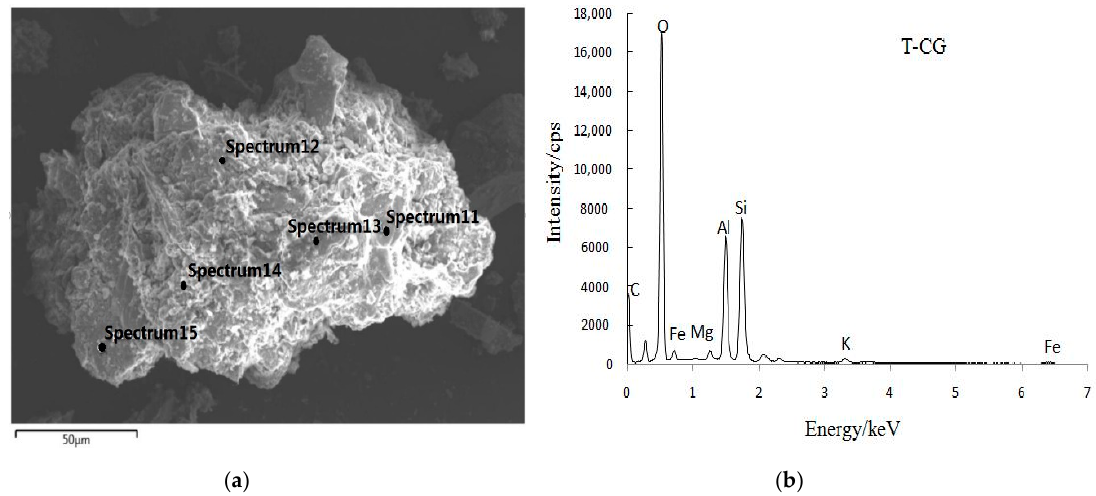
Figure 7. SEM and EDS spectrum of T-CG. ( a ) SEM Spectrum of T-CG; ( b ) EDS Spectrum of T-CG.